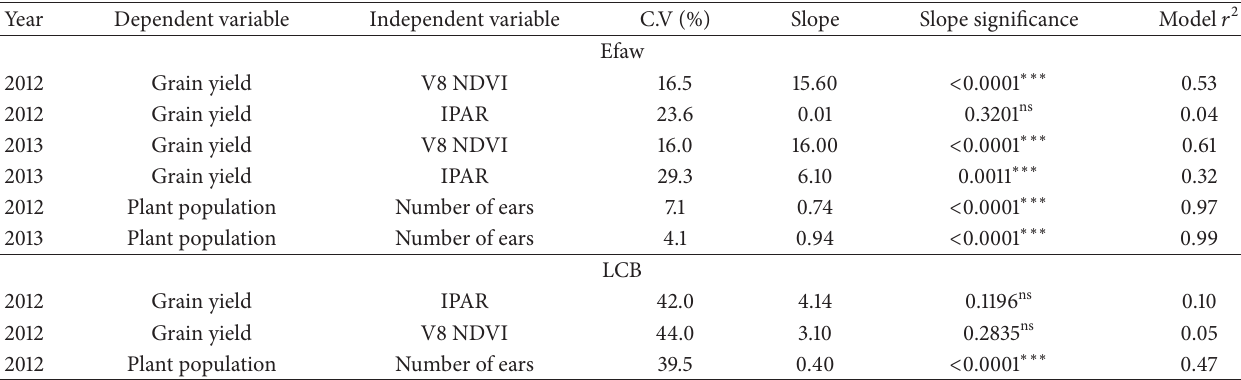
Table 2: Linear regression results including coefficient of variation, 𝑟 2 , slope, and slope significance for the relationship between grain yield with normalized difference vegetation index (NDVI) and intercepted photosynthetically active radiation (IPAR) and between plant population at harvest and number of ears harvested at LCB and Efaw locations, 2012 and 2013.